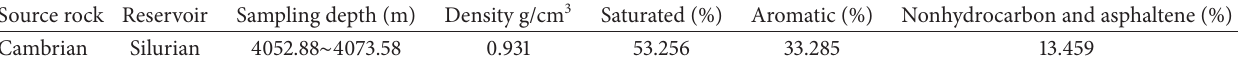
Table 2: Characteristics of the crude oil sample from Cambrian source rocks in Tz62 well.